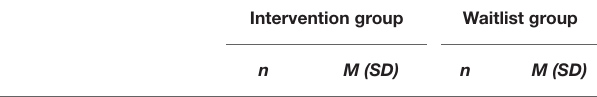
TABLE 4 | Mean and standard deviations for secondary outcome measures regarding maternal functioning at each measurement